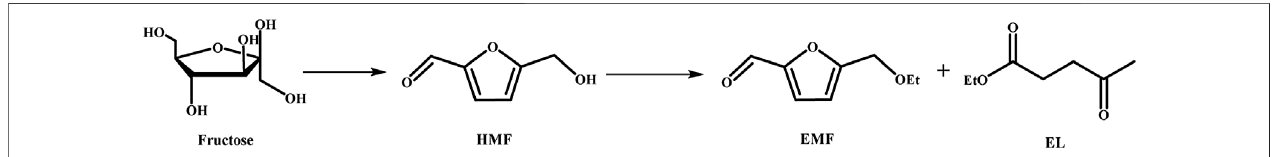
FIGURE 5 | Synthesis of EMF from